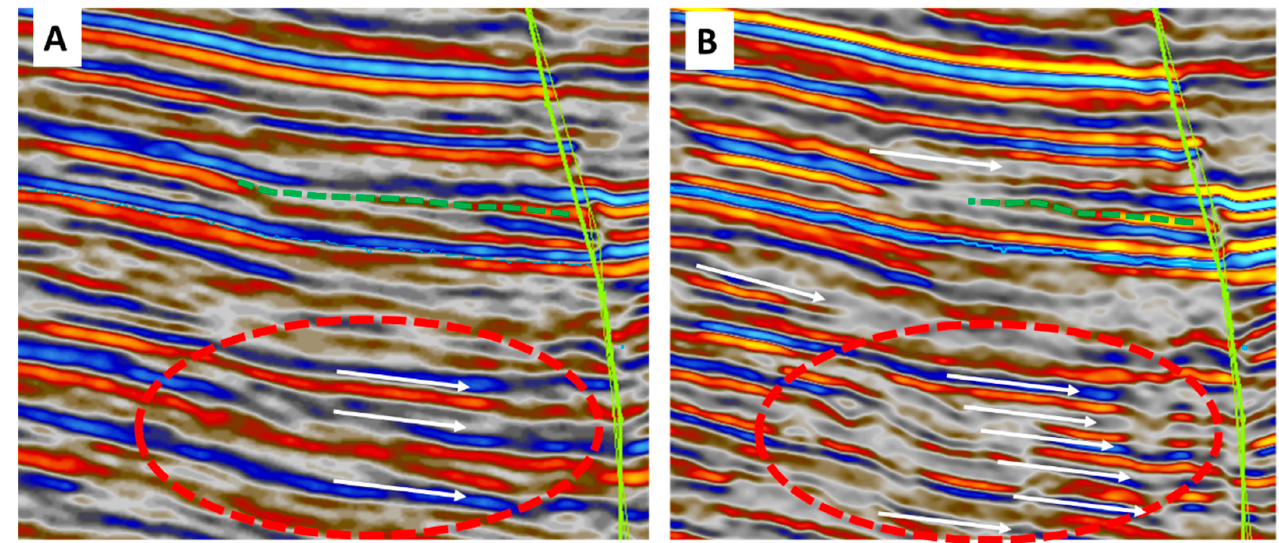
Figure 20. Sections from seismic data showing the difference between bandlimited and enhanced data. ( A ) bandlimited data, ( B ) enhanced data.